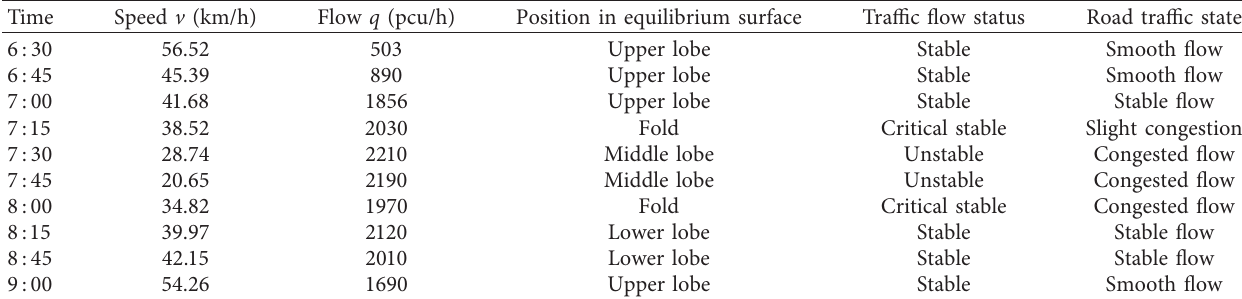
Table 6: Road traffic flow